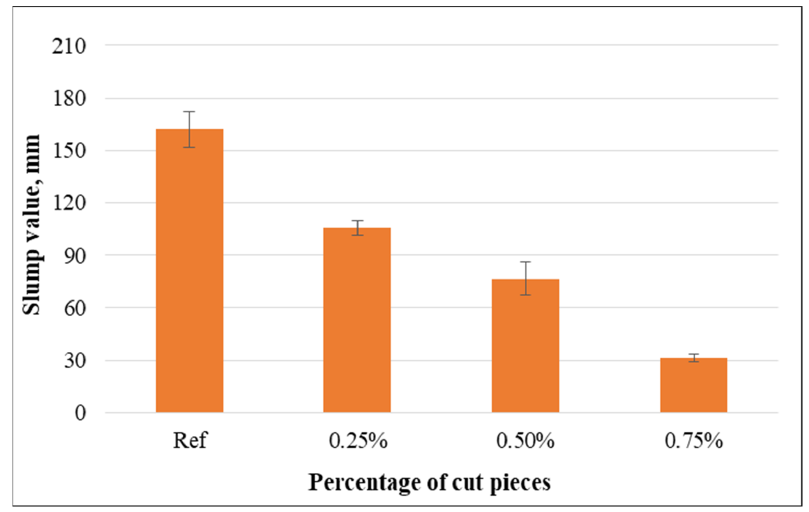
Figure 14. Relationship between slump values and volume fraction of non ‐ woven tissue .